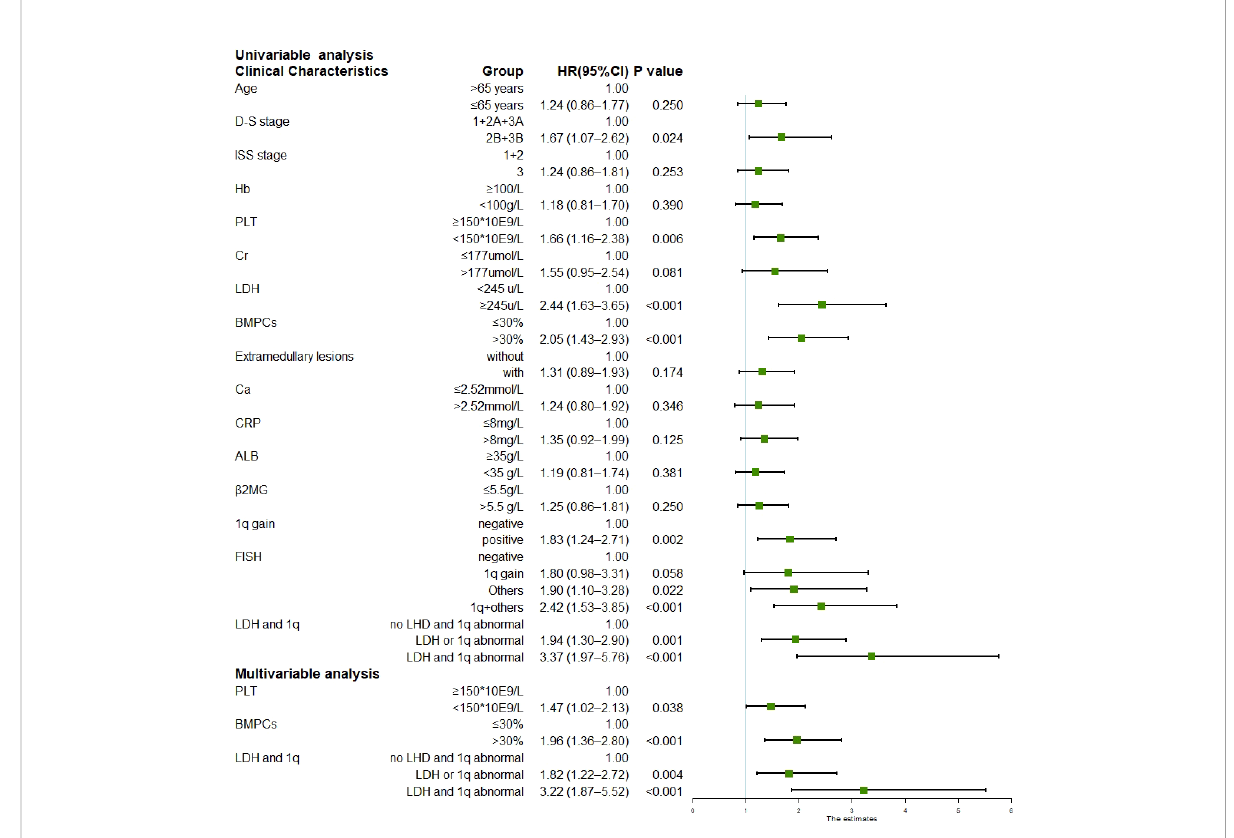
FIGURE 1 Univariable and multivariable analysis for progression-free survival (Data can be found in Supplementary Table